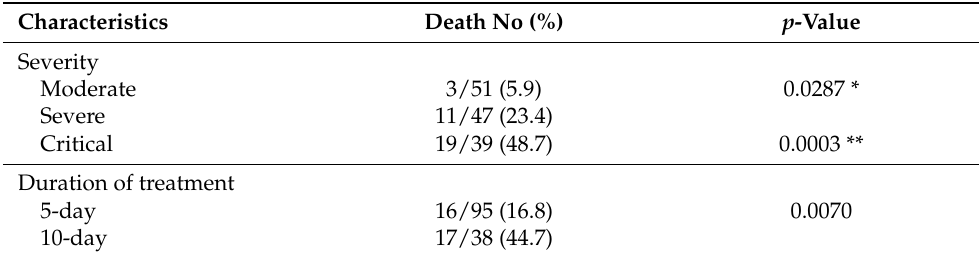
Table 3. Death rate of patients treated with